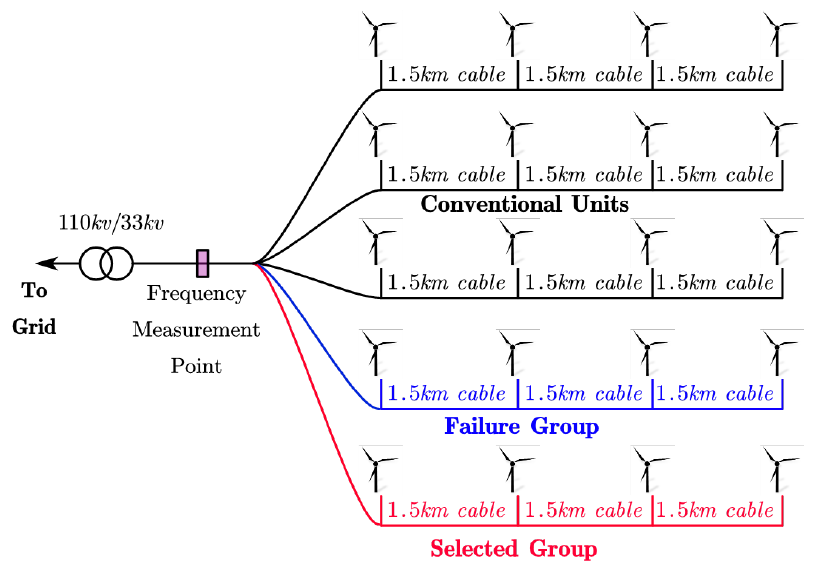
Figure 11. Units connection structure in the tested wind farm.